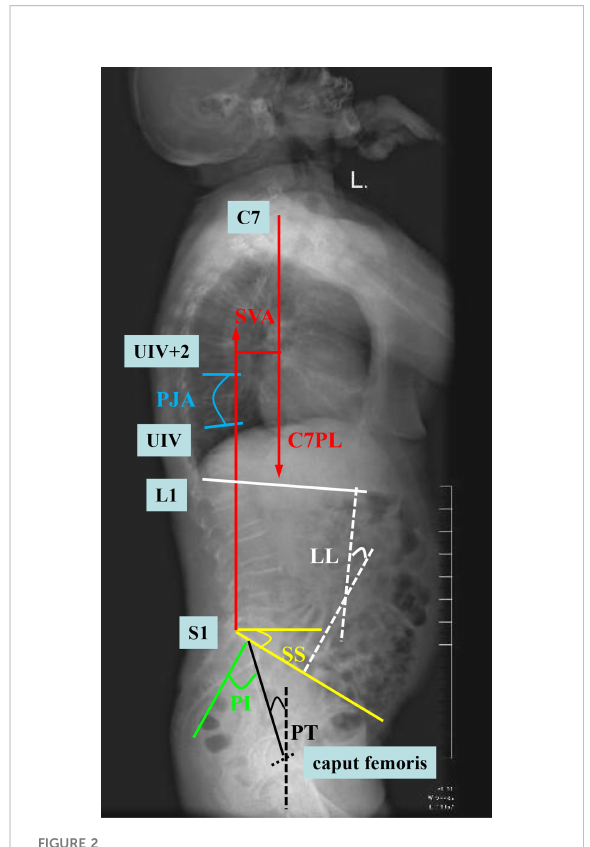
FIGURE 2 Diagram of the measurement of imaging data. SVA (sagittal vertebral axis; red line), PJA (proximal junction angle; blue line), LL (lumbar lordosis; white line), PI (pelvic incidence; green line), PT (pelvic tilt; black line), and SS (sacral slope; yellow